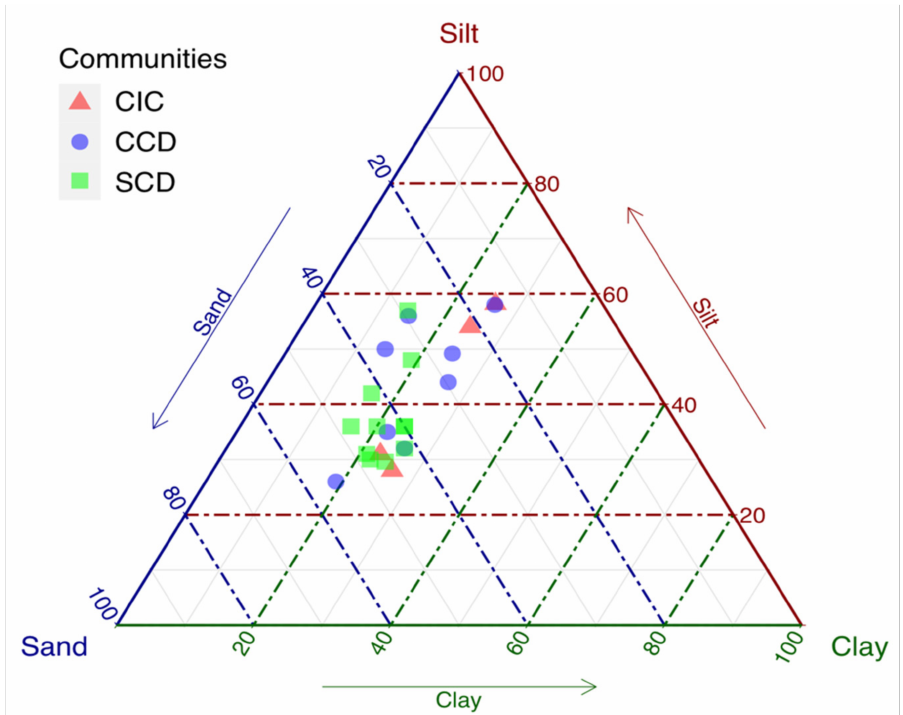
Figure 5. Ternary plot demonstrating the distribution pattern of communities on the basis of soil texture (clay, sand, and silt). (For the complete names of plant communities, see Figure